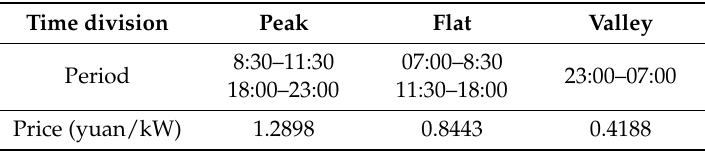
Table 2. Time of Use (TOU) price of 24 h.